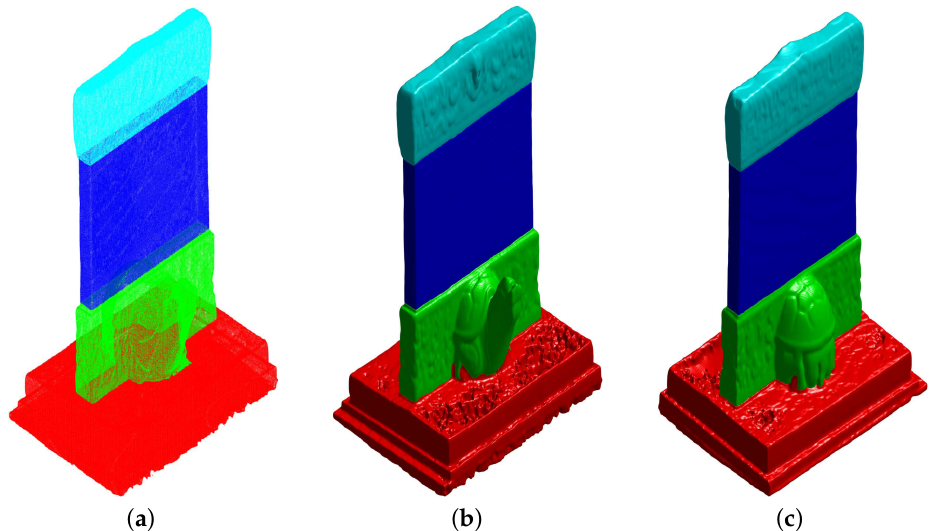
Figure 7. Four-component surface reconstruction of real point clouds. ( a ) Input data set. ( b , c ) Final reconstructions with different views.